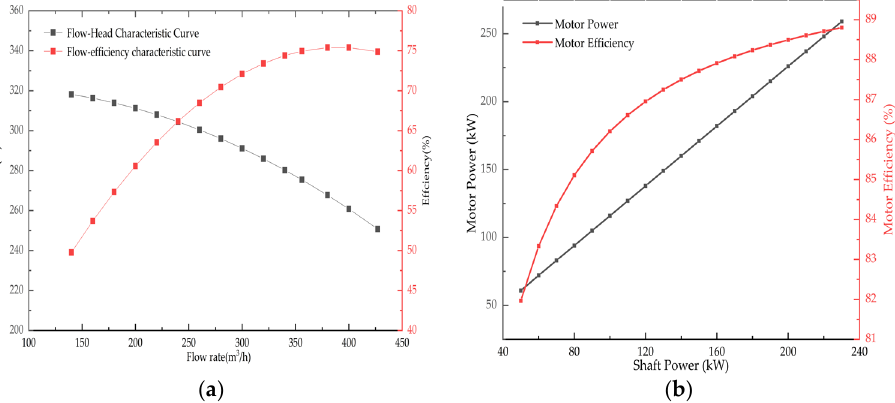
Figure 4. LNG submerged pump performance: ( a ) LNG submerged pump characteristic curve; ( b ) LNG submerged pump motor performance curve.